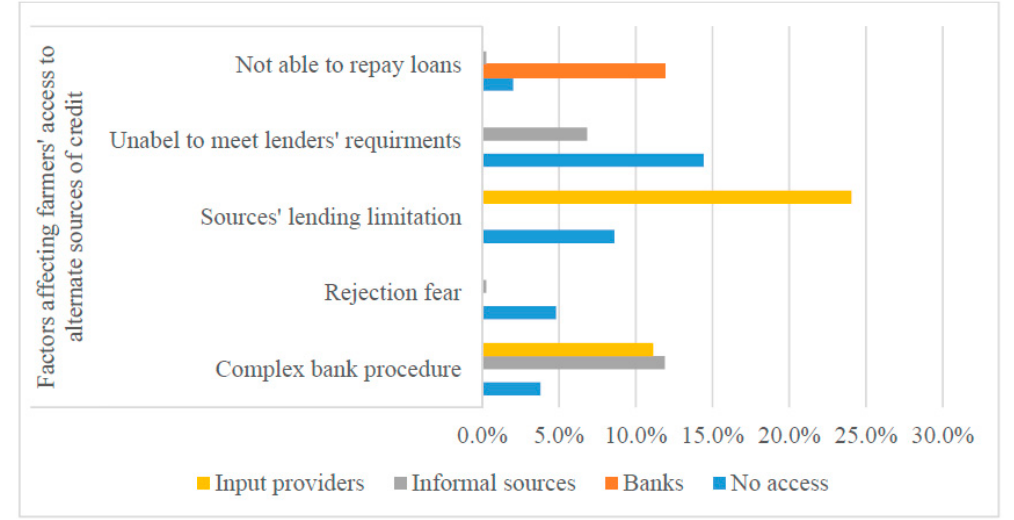
Figure 2. Factors a ff ecting farmers’ access to alternate sources of Figure 2. Factors affecting farmers’ access to alternate sources of credit.